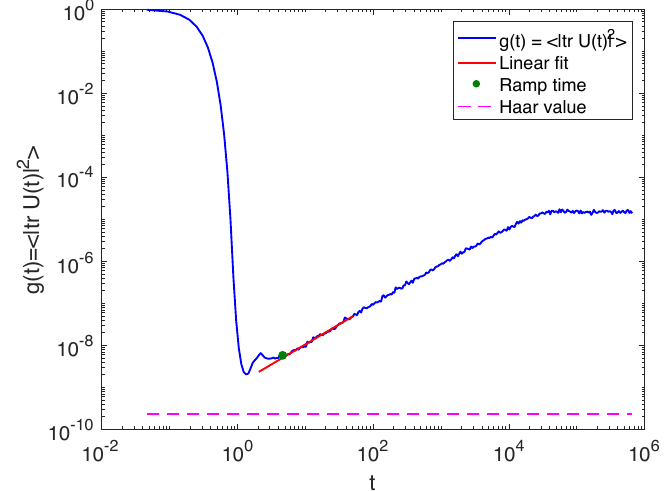
Figure 7 . The spectral form factor for the k -local randomly coupled qubits (RCQ) for N = 16 qubits is given by the blue curve. We (cid:12)t a line to the ramp (red line) and determine the time where the fractional error from the linear (cid:12)t (cid:15) ( t ) equal to 5 % ; 10 % ; 20 % or 30 %. In the plot the green dot represents the ramp time estimate when fractional error is 10